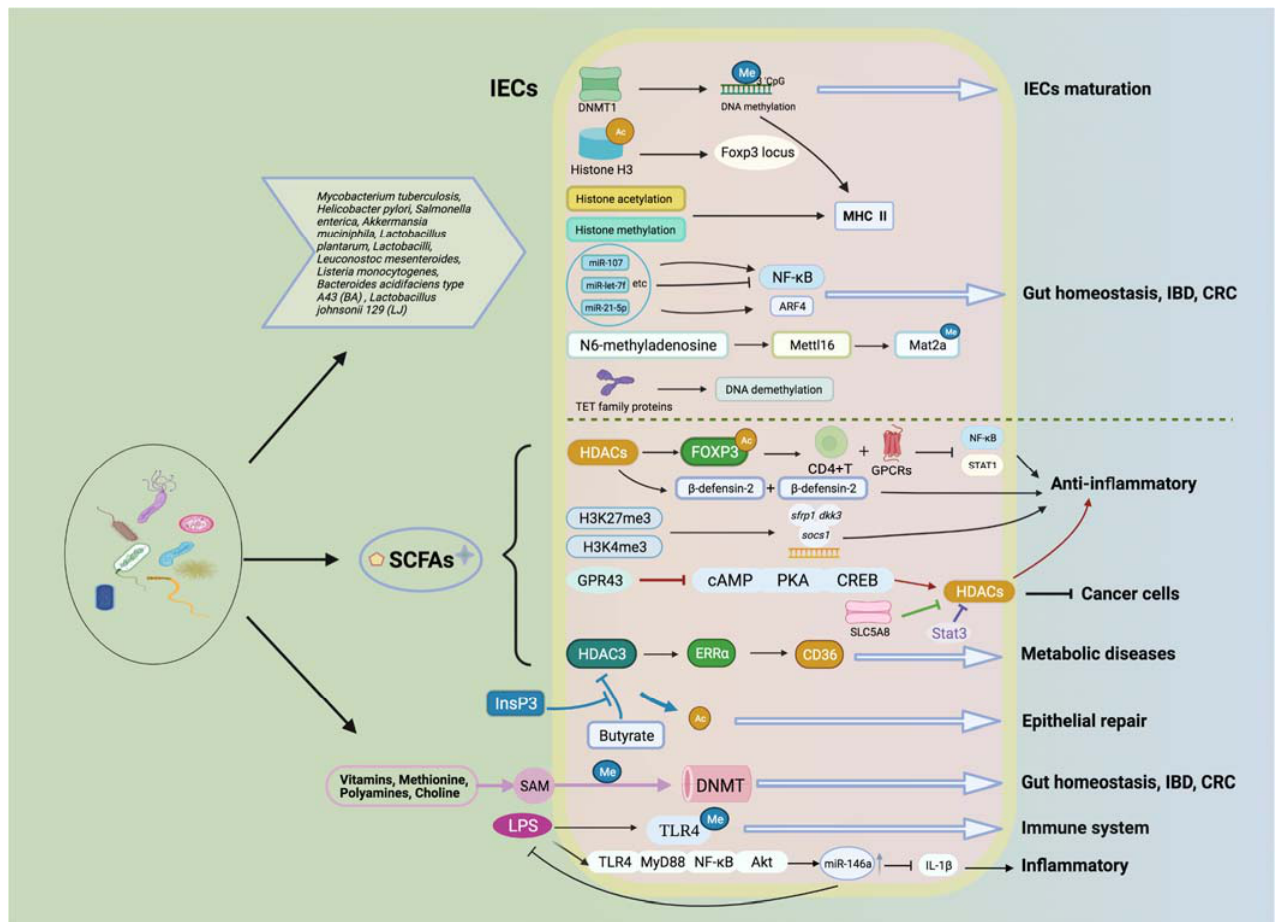
Figure 3. Gut microbiota and its metabolites affect health and diseases via multiple epigenetic pathways. Gut microbiota along with its metabolites (e.g., SCFAs) are involved in health and disease through multiple epigenetic mechanisms, including affecting transporter activities (e.g., DNMTs, HMT, HAT, and HDACs), providing methyl donors to participate in DNA methylation and histone modifications, and miRNAs that can lead to gene transcriptional modifications. These mechanisms can participate in a variety of biological processes, such as the maturation of IECs, the maintenance of intestinal homeostasis, inflammatory response, the development of metabolic disorders, and the prevention of colon cancer.